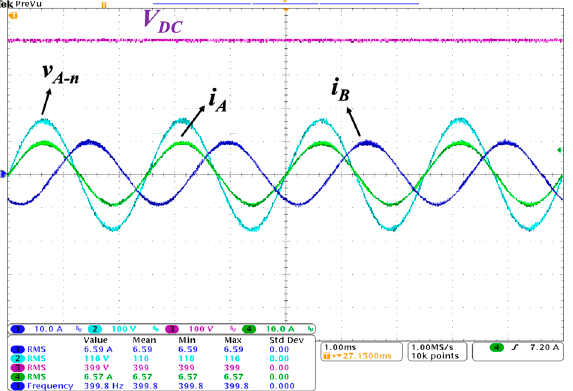
Figure 10. Waveforms of the 3-phase active Boost PFC converter integrated with EMI Stage: V DC = 400 V; V A-n = 115 V (RMS); P out = 2.3 kW.